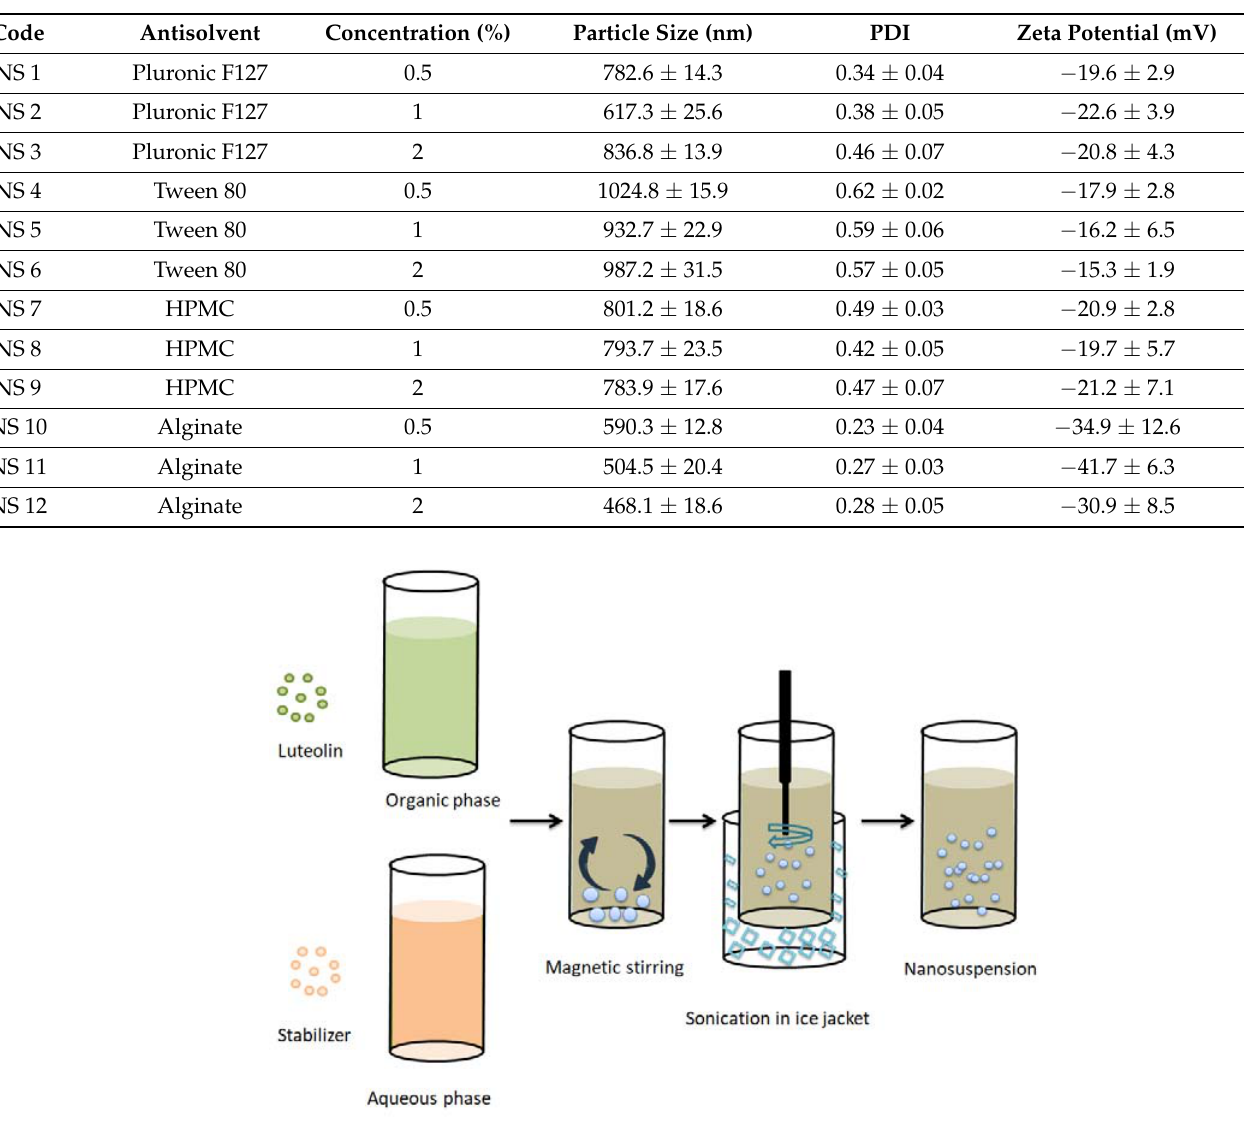
Figure 1. Schematic representation of the antisolvent/precipitation sonication method used for the preparation of LT-loaded